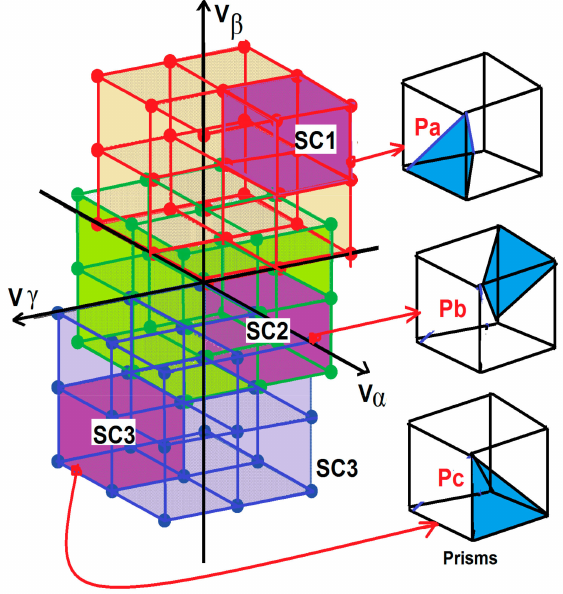
Figure 6. Separation of subcubes with various